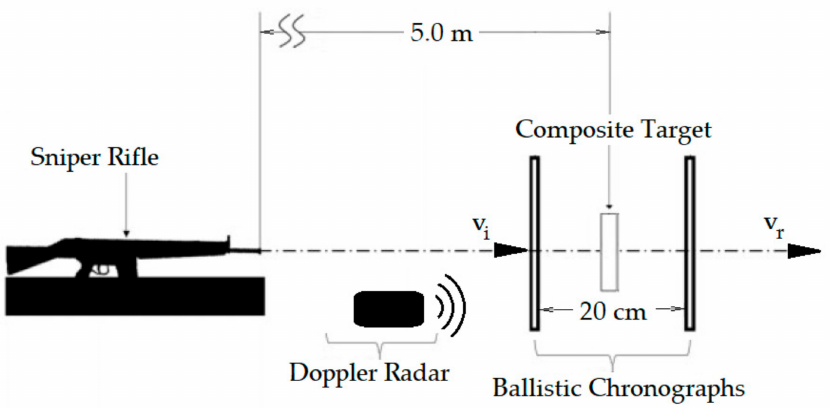
Figure 6. Schematic diagram of the setup arrangement at the Military Institute of Engineering (IME) for composite standalone ballistic test. Adapted from the work in [5].